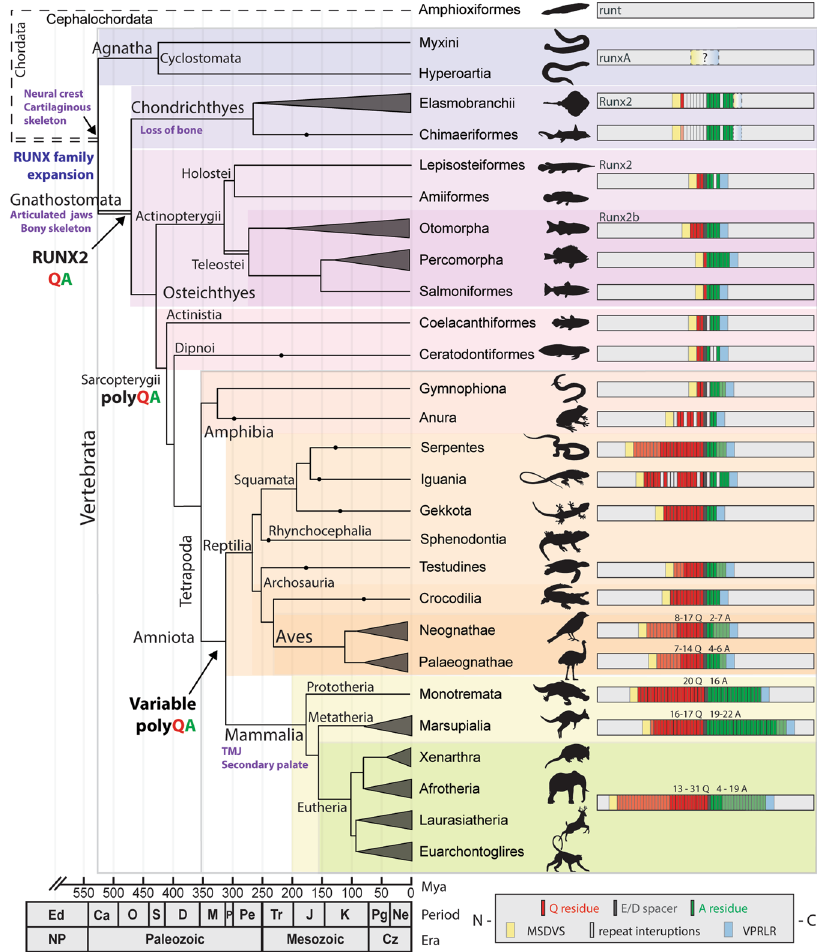
Fig. 3 RUNX2 QA repeat evolution throughout vertebrates. Simpli fi ed phylogeny showing the evolution of the RUNX2 QA repeat during vertebrate history. Evolutionary relationships between major vertebrate radiations are shown with median divergence times. Representative species of each group are shown by silhouettes, and repeat structures with Q, spacer, and A residues are shown for each group on the right. The QA repeat emerged in the last common ancestor of gnathostomes and can be observed in all subsequent extant lineages. The repeat continued to expand throughout early tetrapods and amniotes, before reaching its long and variable modern condition in eutherian mammals <100 million years ago. Taxa silhouettes were created from images under a CC BY 4.0 open